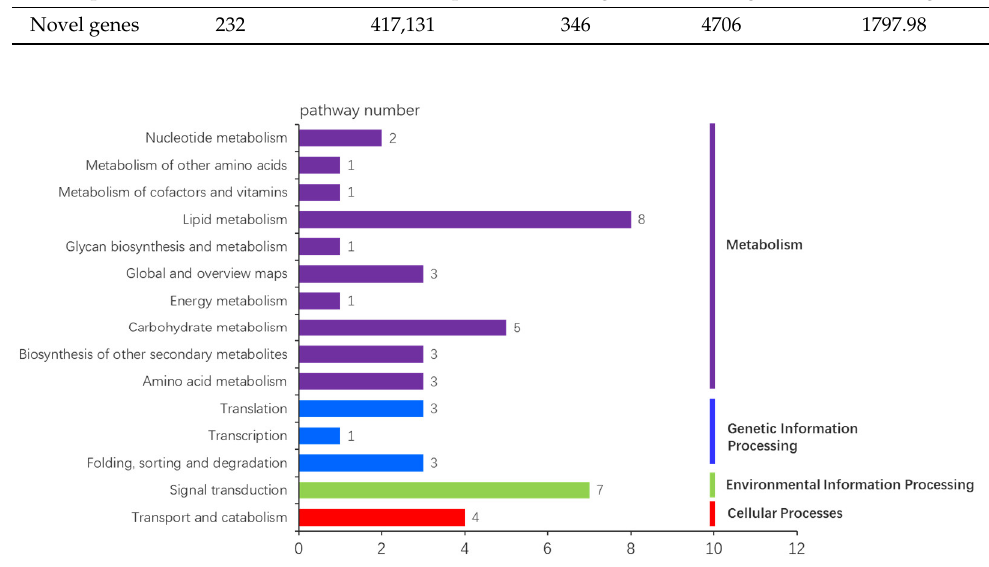
Table 4. Summary of novel genes analysis.